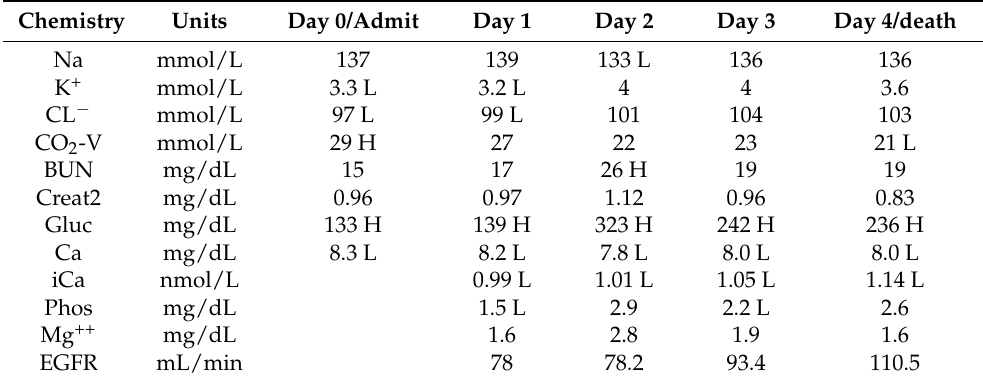
Table 5. Blood chemistry profile.